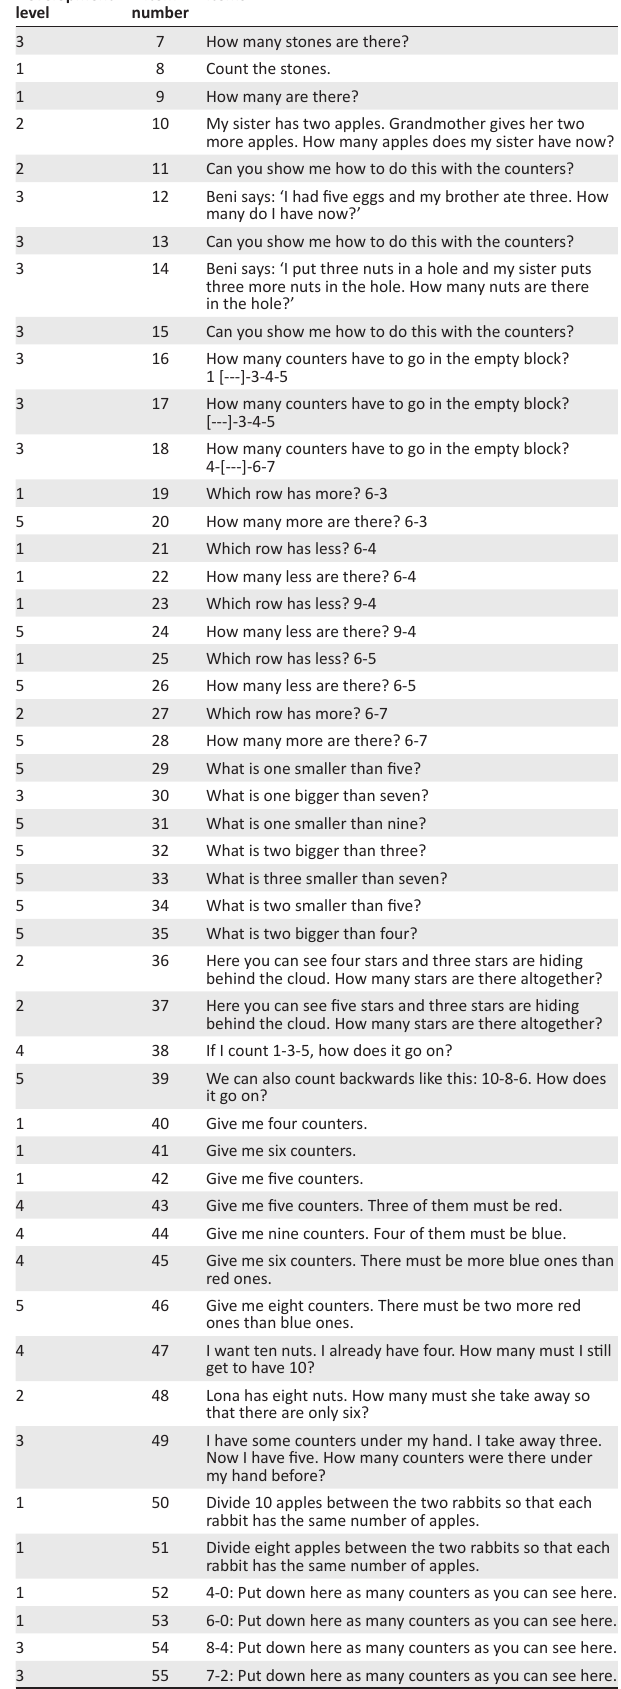
TABLE 3 (Continues...): Mathematical and Arithmetic Competence Diagnostic items according to development levels. Development